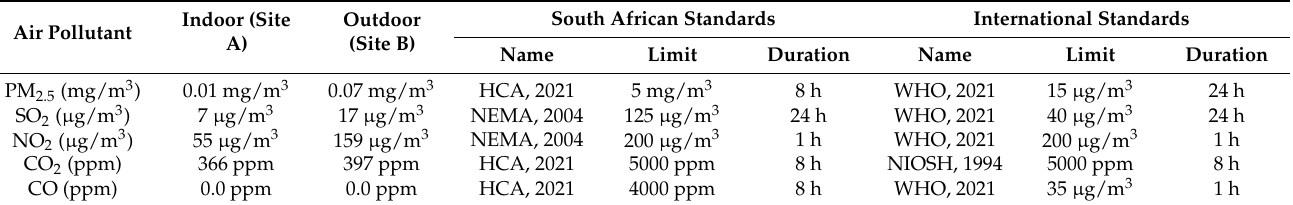
Table 2. Descriptive statistics for stall daily air pollutants (static sampling) and recommended exposure levels at vendor markets in the inner city,